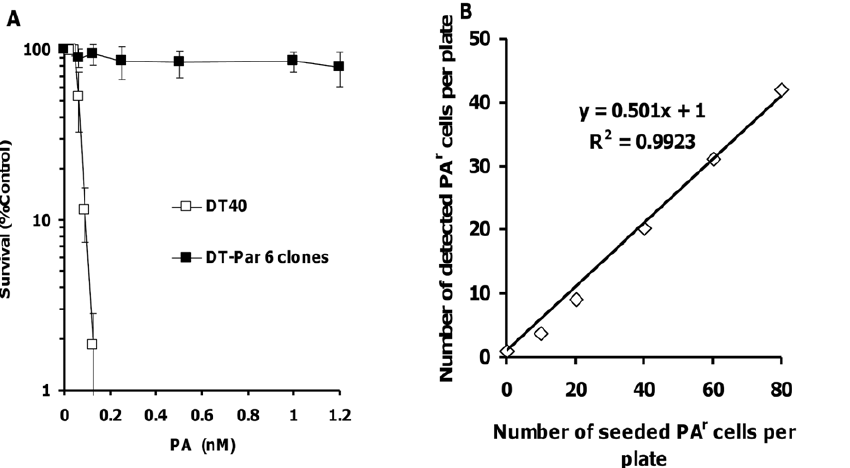
Figure 3. Characterization of PA-resistant (PA r ) DT40 cells and validation of PA selection-based GPI anchor-deficient cell detection assay. ( A ) In a low cell density experiment using a 24-well plate (2.5 6 10 3 cells/250 m L/well), the intact DT40 cells and six different clones of DT40 cells that survived from the first PA treatment at 1.2 nM were exposed to PA (0.0221–1.2 nM). After a three-day cultivation, cell viability was determined by XTT. Each point represents the mean and S.D. (bars) from three independent experiments for DT40 cells and single experiment for six different clones of DT40 cells resistant to PA. ( B ) Using one of the PA r clones used for Figure 3A, different numbers of PA r cells (0 to 80 cells/plate) were seeded onto 96-well plates containing intact DT40 cells (40 6 10 3 cells/well) to validate the accuracy of the PA selection step of the assay. The cells were exposed to PA at 1.2 nM. After a seven-day incubation, colony formation was scored visually using an inverted microscope. Plating efficiency was also determined using PA r